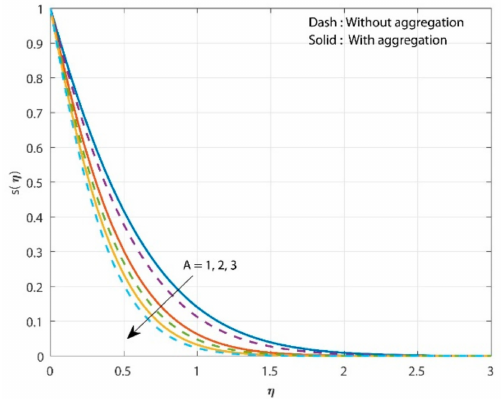
Figure 3. Influence of acceleration parameter on s